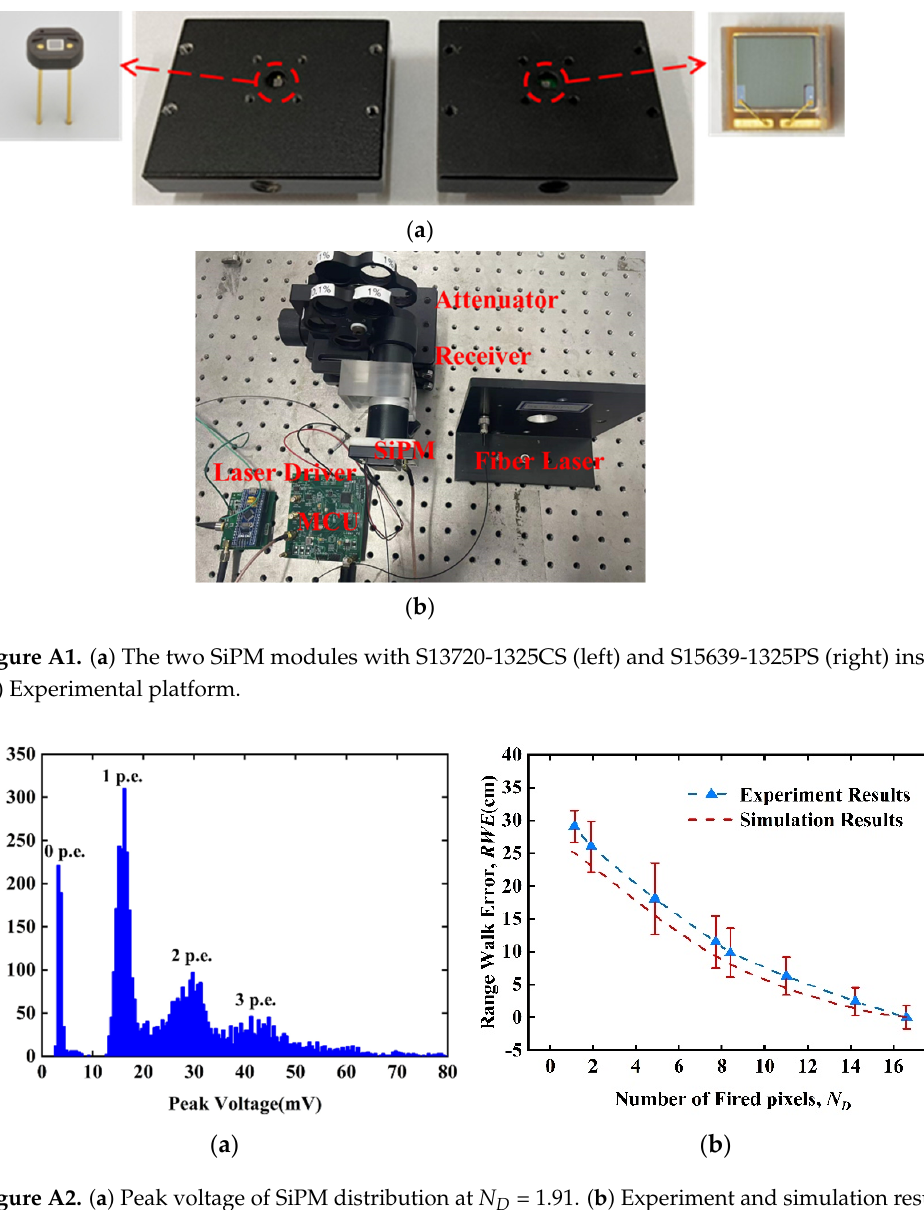
13 of 15 Table A1. Comparison of the two types of SiPM. Parameter